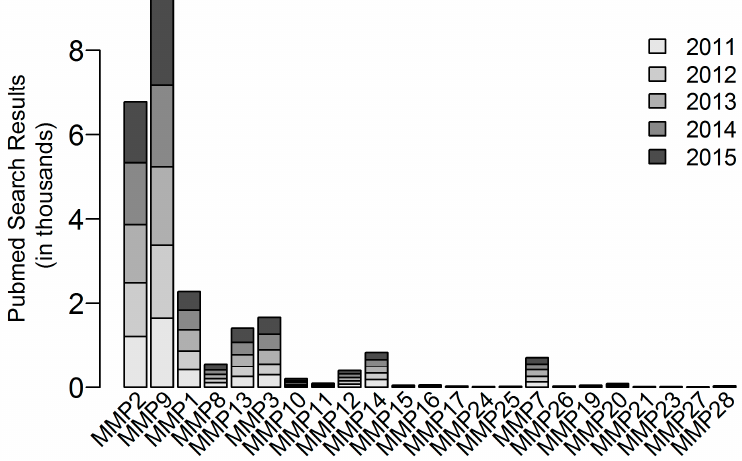
Figure 2. Literature distribution by keyword searches for the several most common names of the family of MMPs. Scale represents 0–10,000 hits in PubMed.